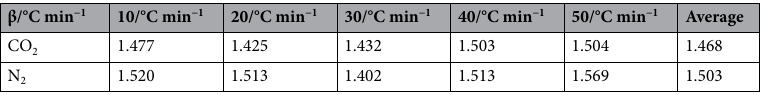
Table 3. Calculations of dynamics index.